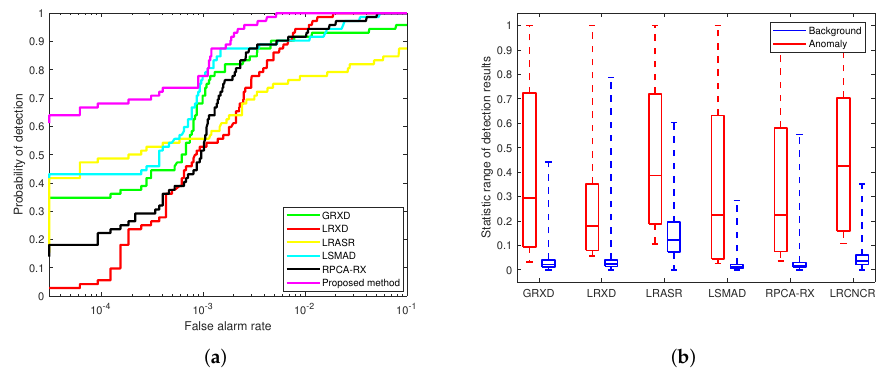
Figure 22. ROC curves and Separability map acquire through the SpecTIR dataset. ( a ) ROC curves. ( b ) Box-plot.